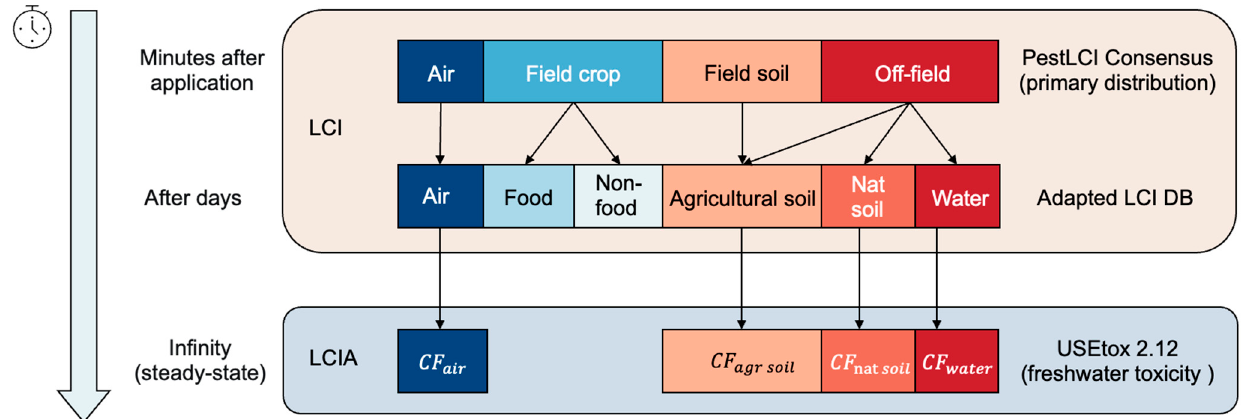
Figure 1. The point of connection between LCI and LCIA in the context of pesticide application for crop production.